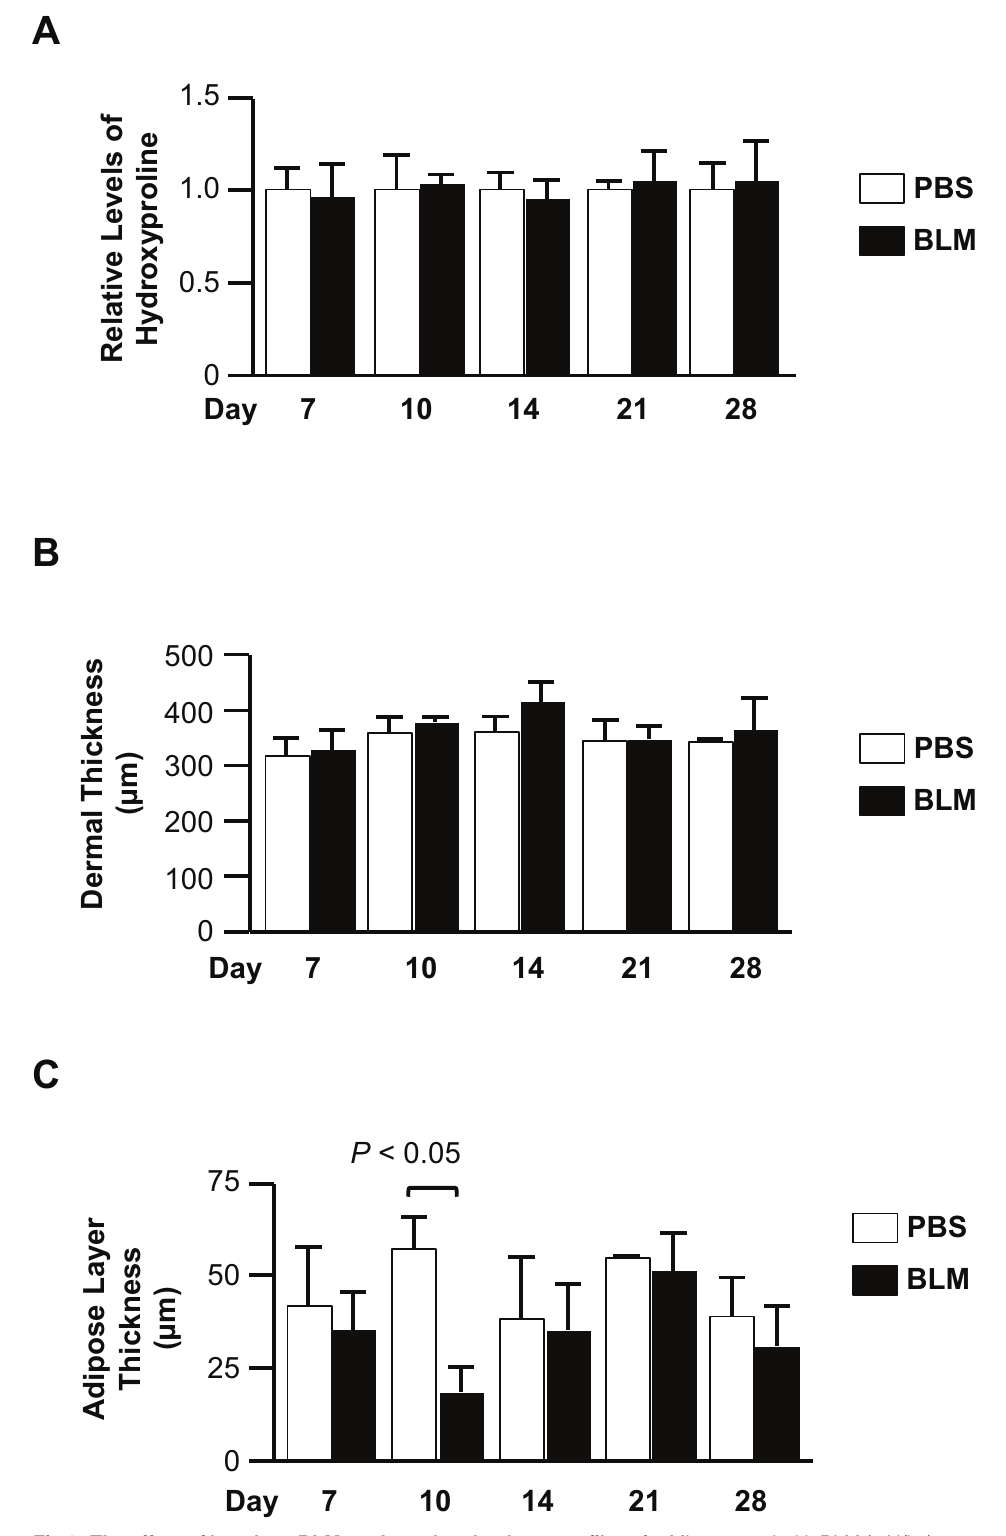
Fig 2. The effect of low dose BLM on dermal and pulmonary fibrosis. Mice treated with BLM (1 U/kg) were sacrificedon days 7 (N = 7), 10 (N = 4), 14 (N = 4), 21 (N = 4), and 28 (N = 4). (A) Hydroxyproline